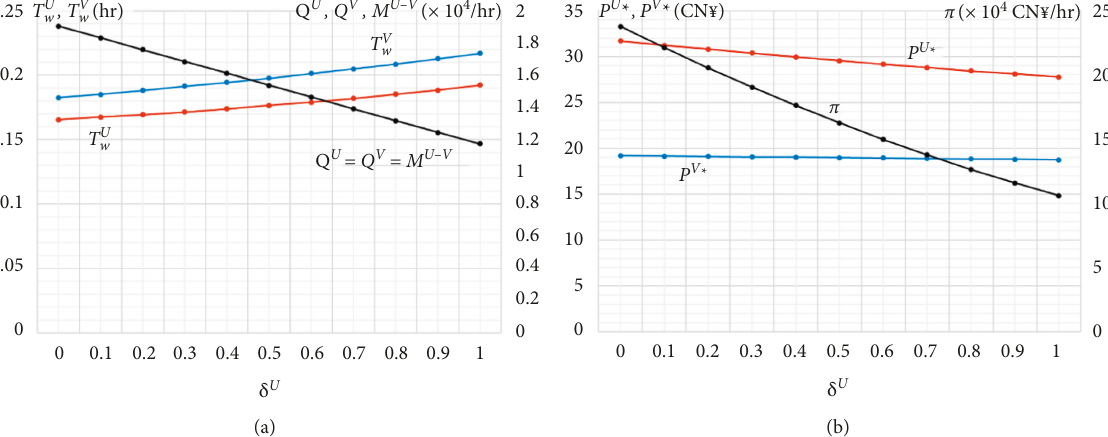
Figure 6: Sensitivity analysis with respect to passengers’ scaling factor. (a) Changes in T U and π .